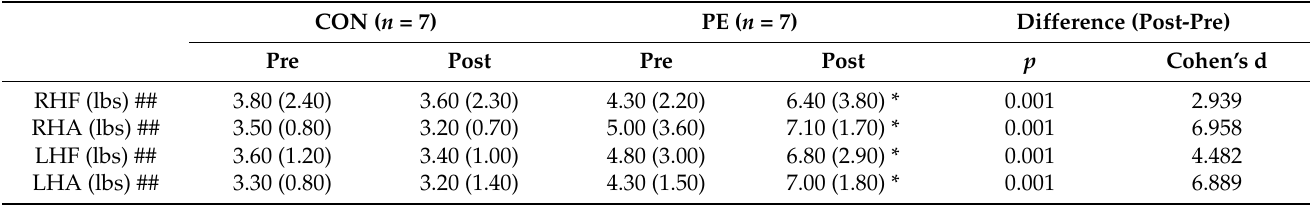
Table 3. Muscle strength in the hip